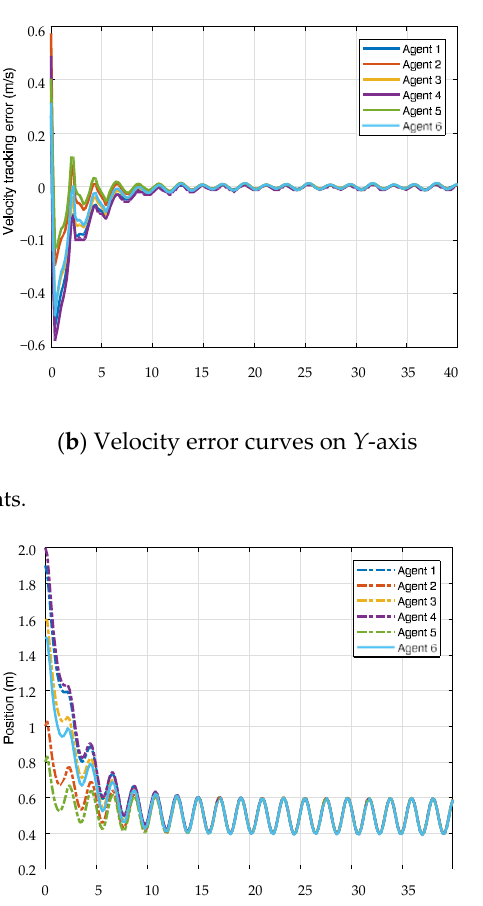
Figure 2. Position error curves of six agents.